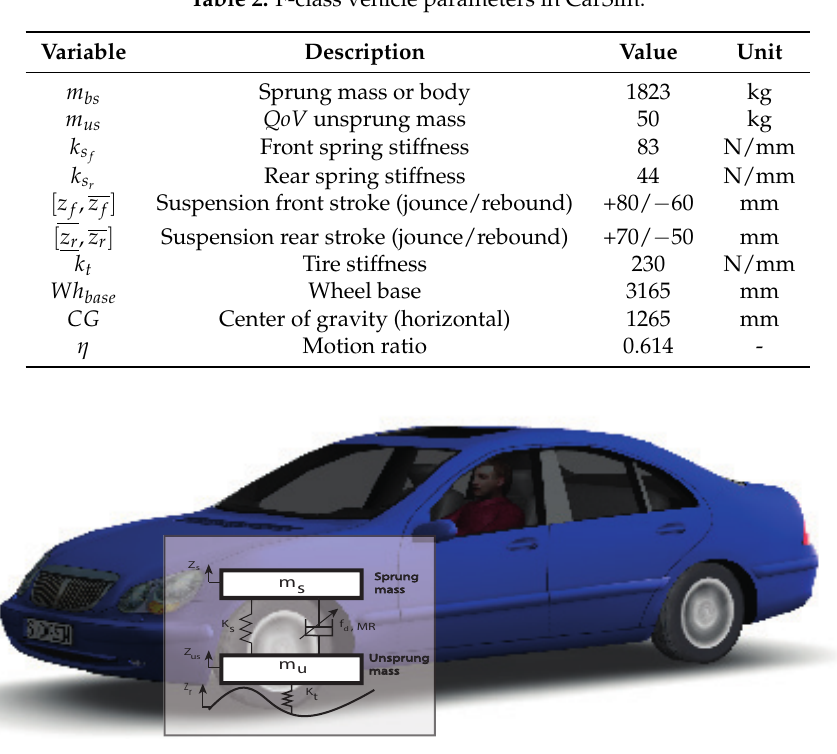
Table 2. F-class vehicle parameters in CarSim.